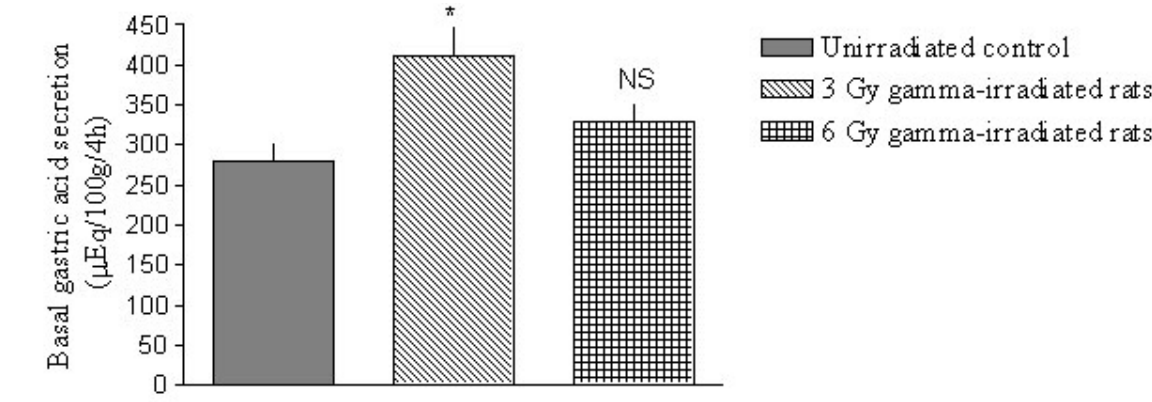
FIGURE 1 . Effect of gamma irradiation on basal (nonstimulated) gastric acid secretion in the 4-h pylorus-ligated rat. Rats were subjected to 3- or 6-Gy gamma irradiation and 7 days later subjected to pylorus ligation together with i.g. 2 ml of physiological saline for 4 h. * p < 0.05; NS: not significant vs. control (unirradiated group).